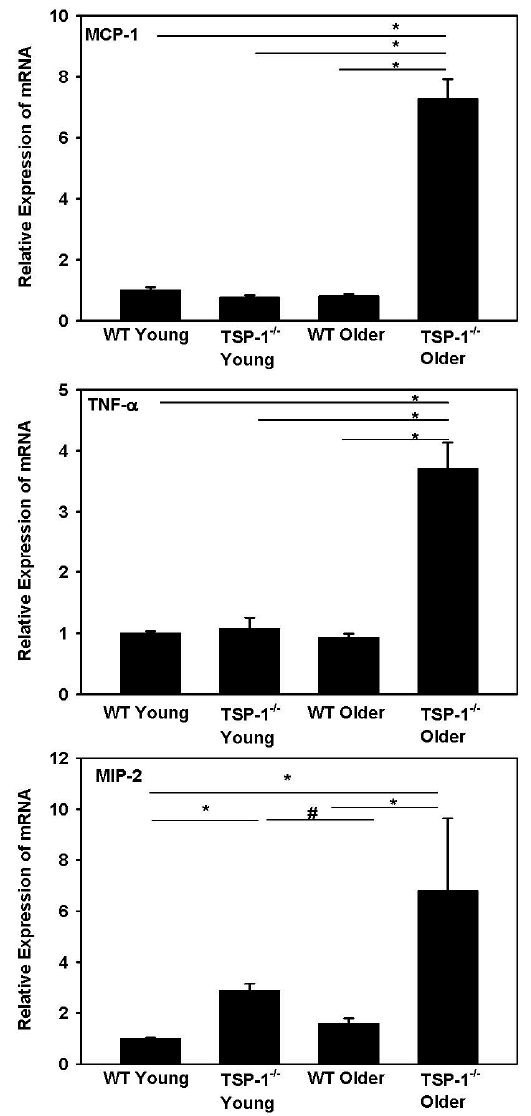
Figure 2. Comparison of monocyte chemoattractant protein-1 (MCP-1), macrophage inflammatory protein-2 (MIP-2), and tumor necrosis factor- α (TNF- α ) expression in wild type (WT) and TSP-1 − / − mouse corneas by quantitative real-time PCR. n = 3. * and # denote significant differences. 2.3. The Number of Monocytes Was Similar in WT and TSP-1 − / − Mouse Corneas